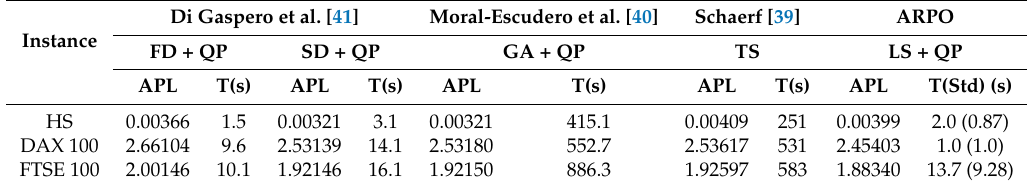
Table 1. Summary of